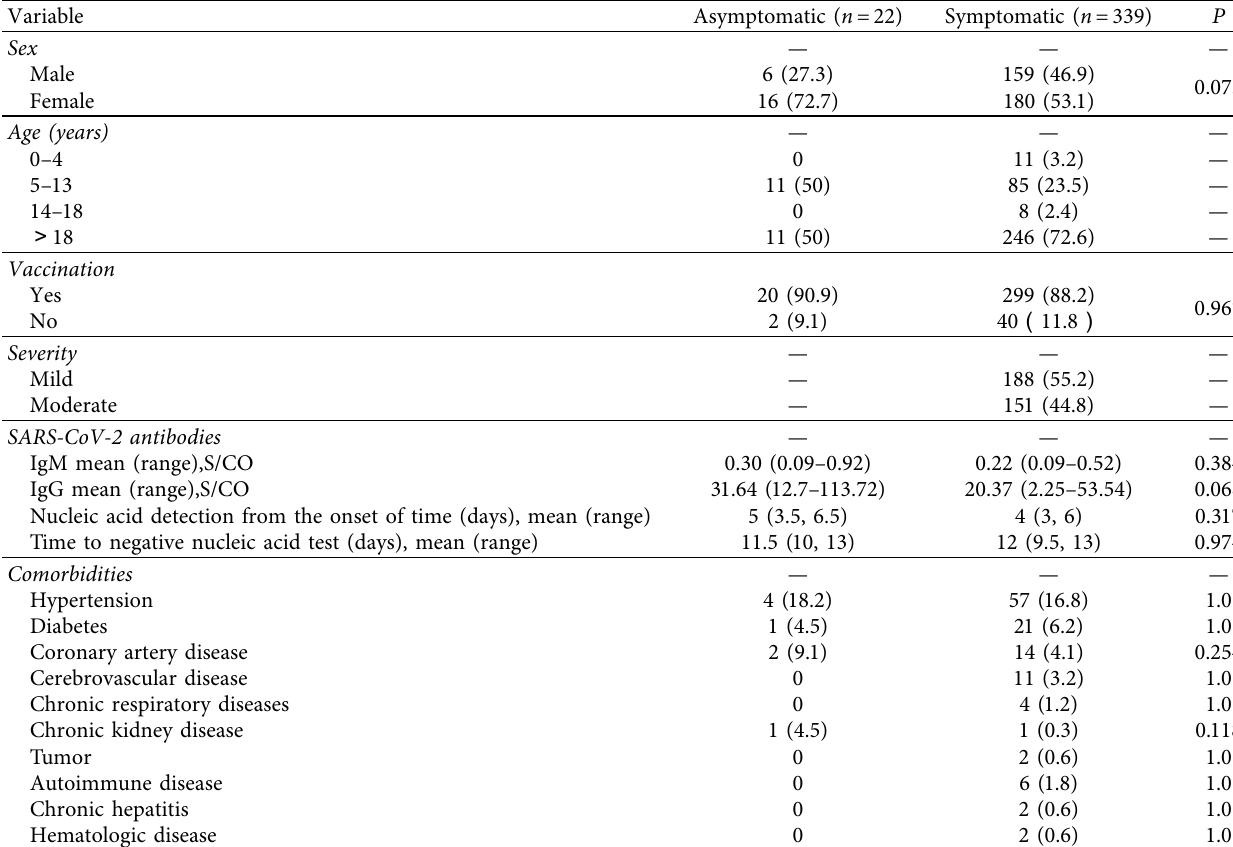
Table 1: Comparison of asymptomatic and symptomatic groups by gender, age group, vaccination status, disease severity, antibody levels, time to negative nucleic acid test, and presence of comorbidities.